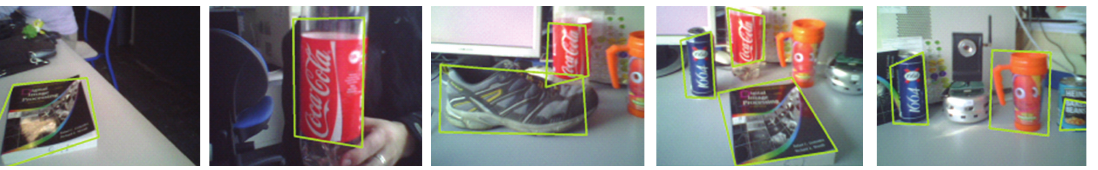
Figure 10: Results relative to a set of objects detection by